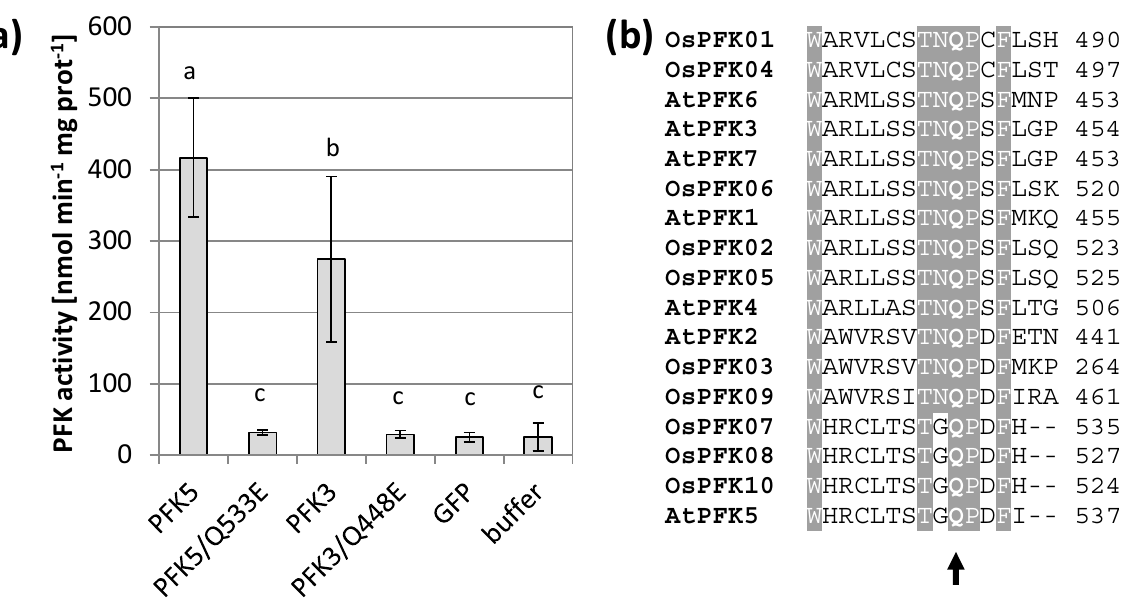
Figure 1. AtPFK5 is an active PFK. ( a ) PFK activity of tobacco leaves transiently transformed with AtPFK5 and AtPFK3 (WT form) compared with mutated variants (glutamine to glutamic acid at positions 533 and 448 for AtPFK5 and AtPFK3, respectively). The results are means ± SD. Different letters indicate significant differences at p < 0.05 (ANOVA, Post hoc Tukey test, n = 4). ( b ) Detail of the protein alignment with the conserved glutamine (Q) marked with an arrow for PFKs from A. thaliana (At) and Oryza sativa (Os).